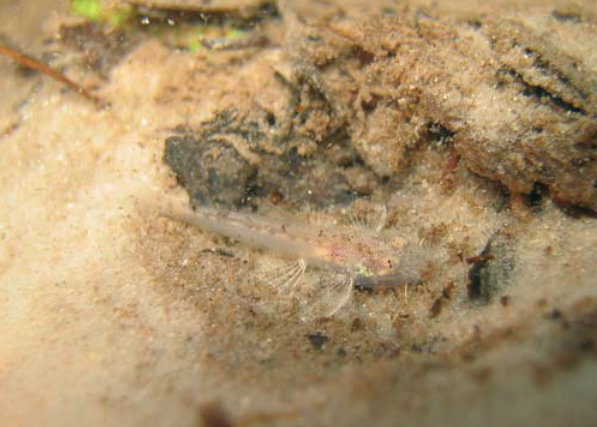
Fig. 3 . The sit-and-wait foraging posture of “ Imparfinis ” pristos in dorsal view. Note translucent body and comma- shaped